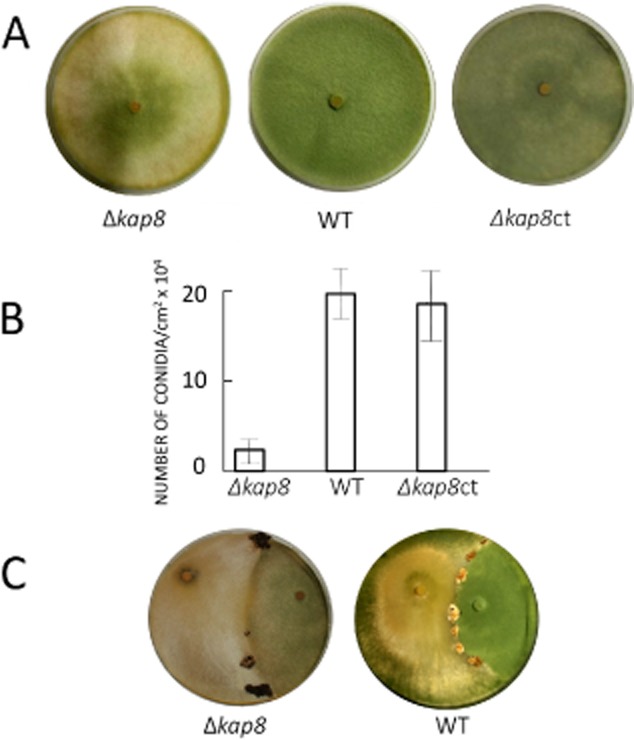
Effect of kap8 knock out on asexual and sexual development in T. reesei:A. Phenotype of Δkap8, the parental strain and the complemented transformant (Δkap8ct) on PDA plates.B. Quantification of conidia harvested from these cultures. Vertical bars indicate standard deviations (n ≥ 3).C. fruiting body formation in confrontation with strain CBS999.79 (MAT1-1).